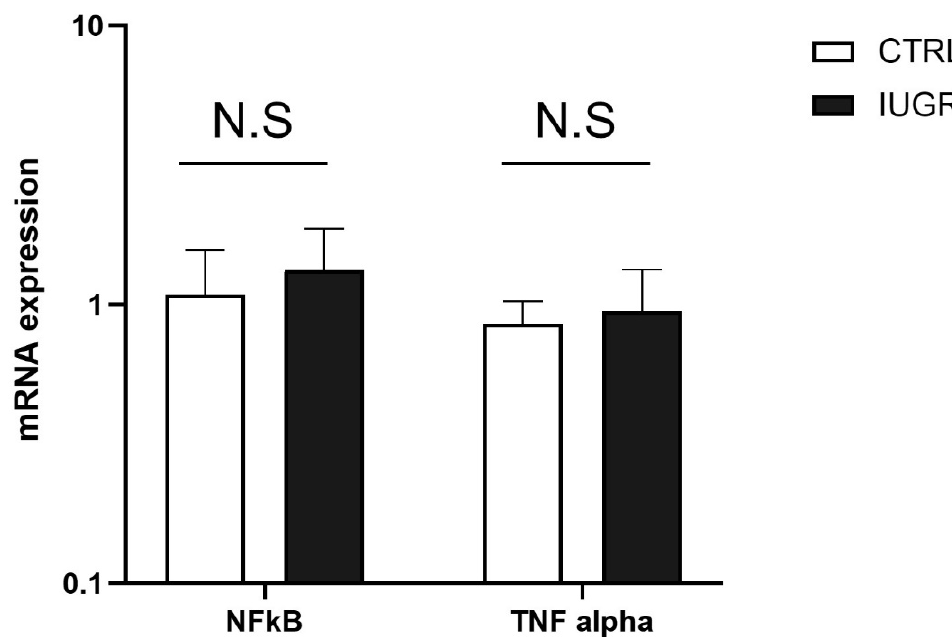
Figure 6. The mRNA expression levels of NFkB and TNF alpha normalized to β -actin were deter- Figure 6 . The mRNA expression levels of NFkB and TNF alpha normalized to β -actin were mined using RT-qPCR in CTRL and IUGR male livers; N.S: not significant. n = 5 determined using RT-qPCR in CTRL and IUGR male livers; N.S: not significant. n = 5 animals/group.